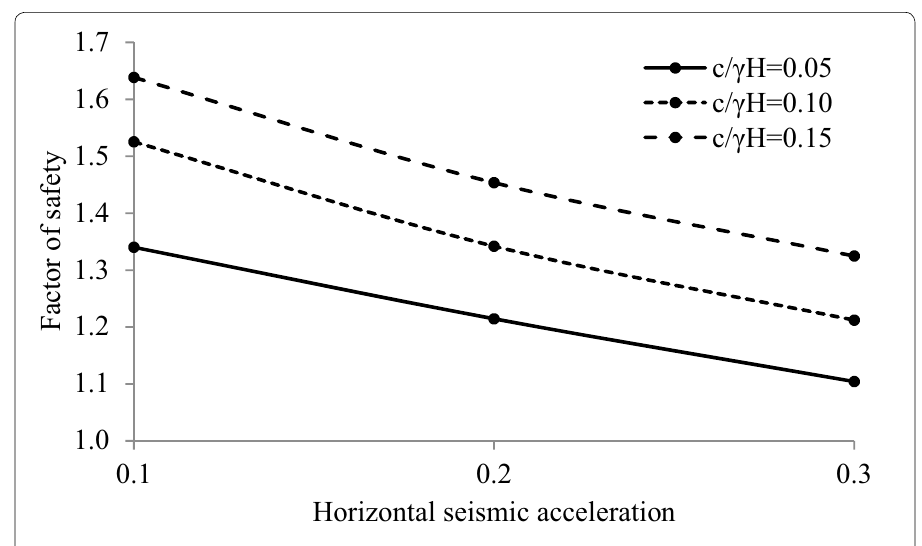
Fig. 8 The variations of factor of safety with cohesion for k v